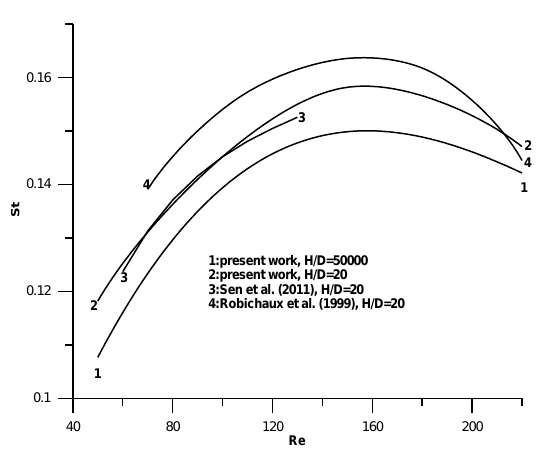
Figure 3. Variation of drag coefficient across a square cylinder for a Newtonian fluid as a function of Reynolds number at different non-dimensional heights of computational domain.